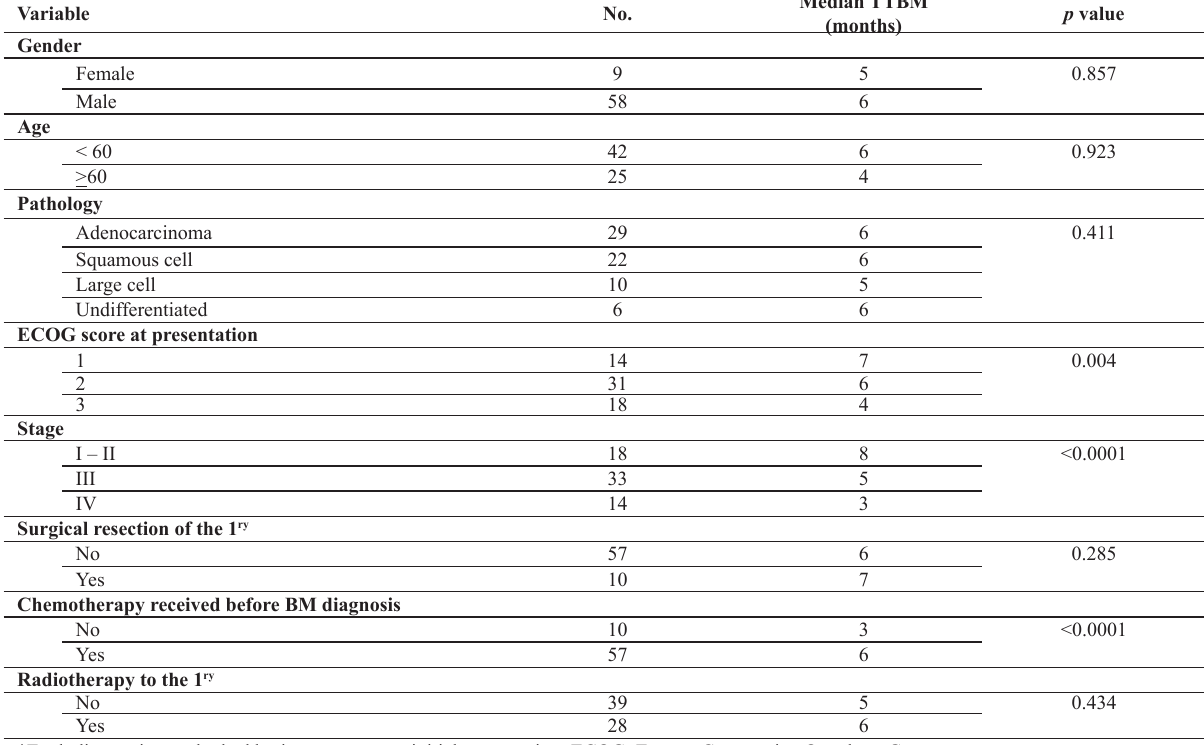
table 3: Analysis of factors affecting the time to brain metastases (TTBM) *